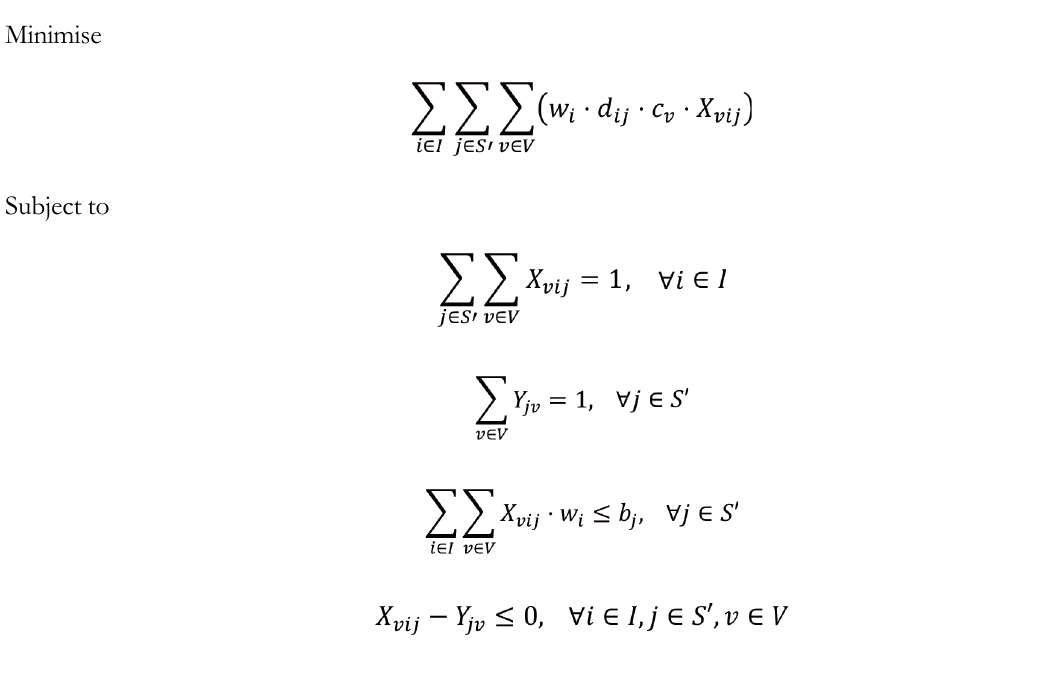
Figure 2. The VNS-based matheuristic